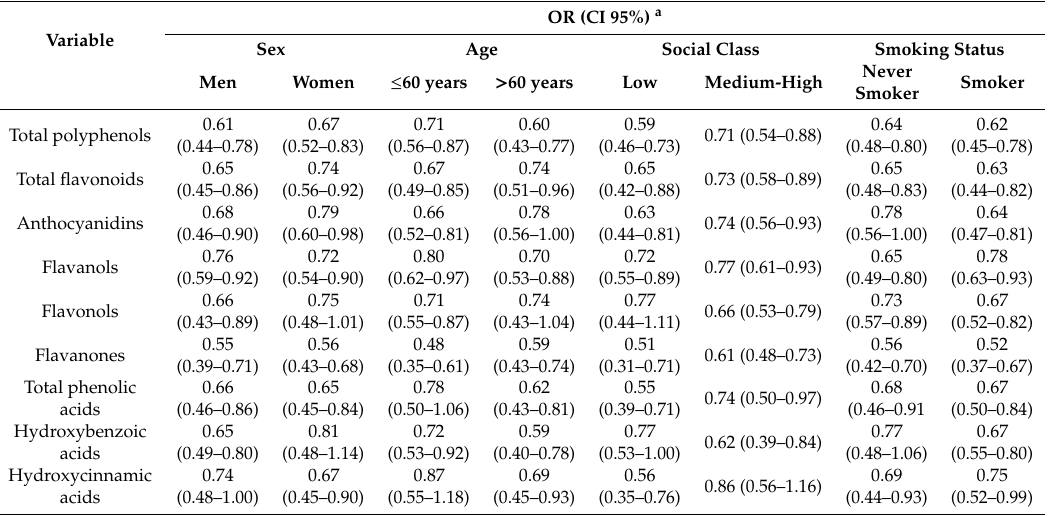
Table 3. Pooled odds ratio (OR) and corresponding 95% confidence interval (CI) of gastric cancer for the highest compared to the lowest study-specific quartile of the distribution of polyphenols classes intake, according to strata of selected